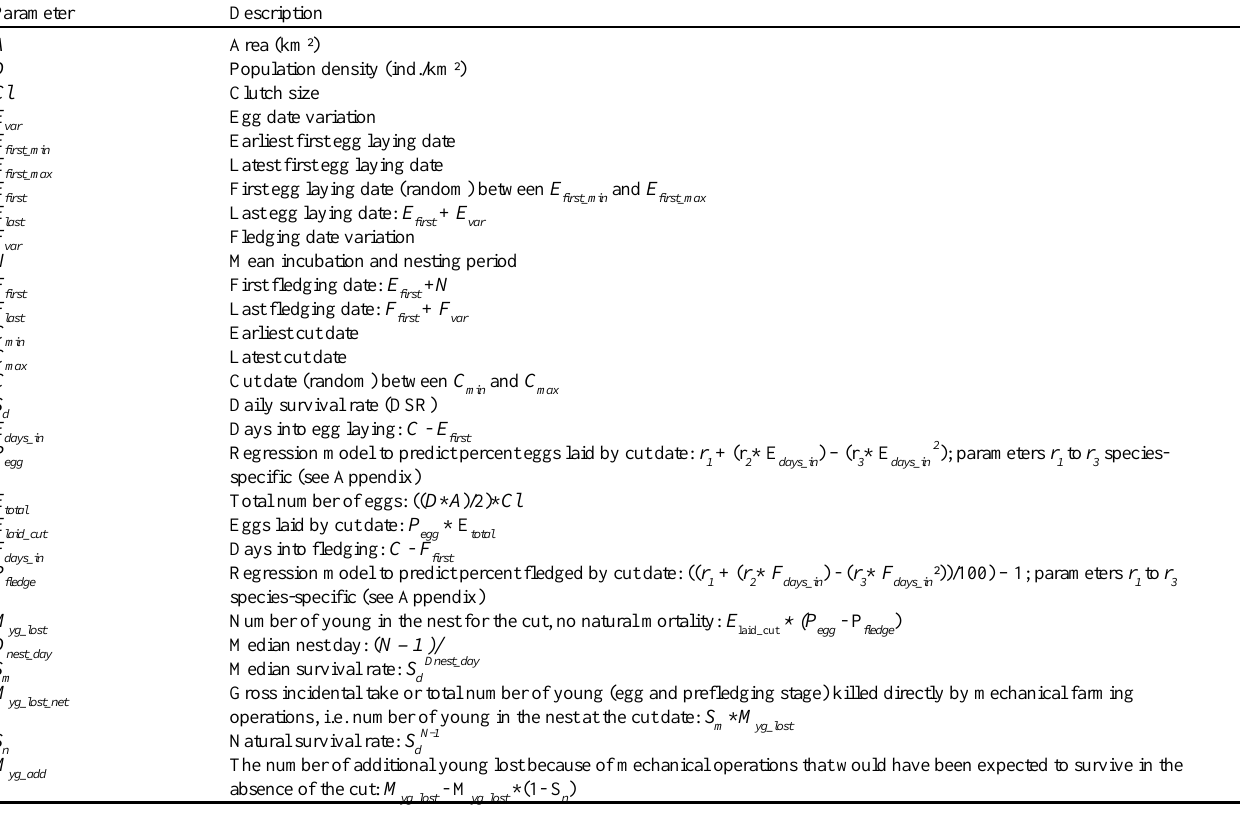
Table 2 . Overview of all model parameters and calculation steps.